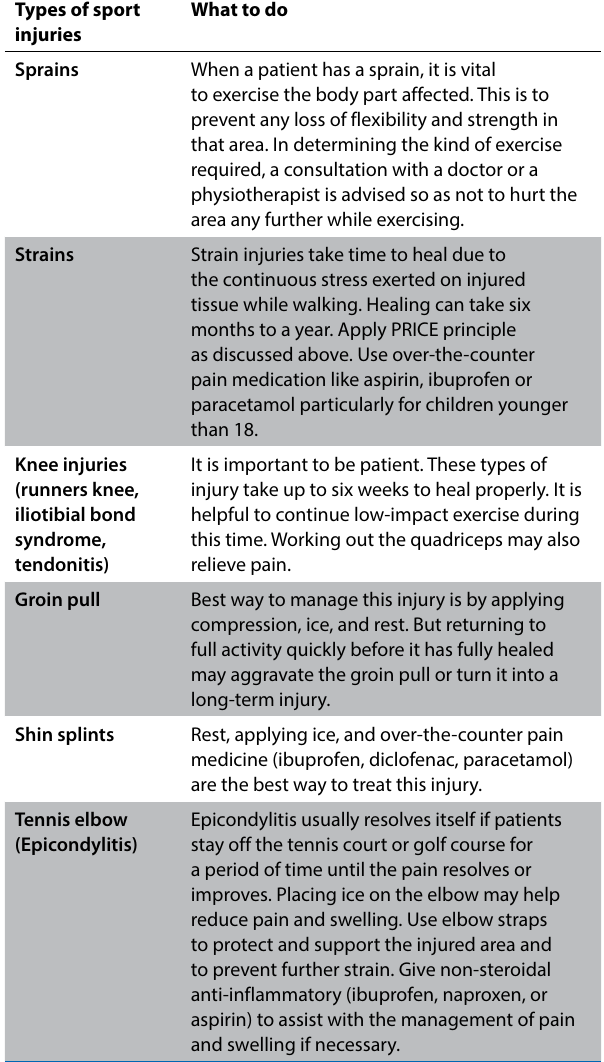
Table 5: Sport injuries and how to manage